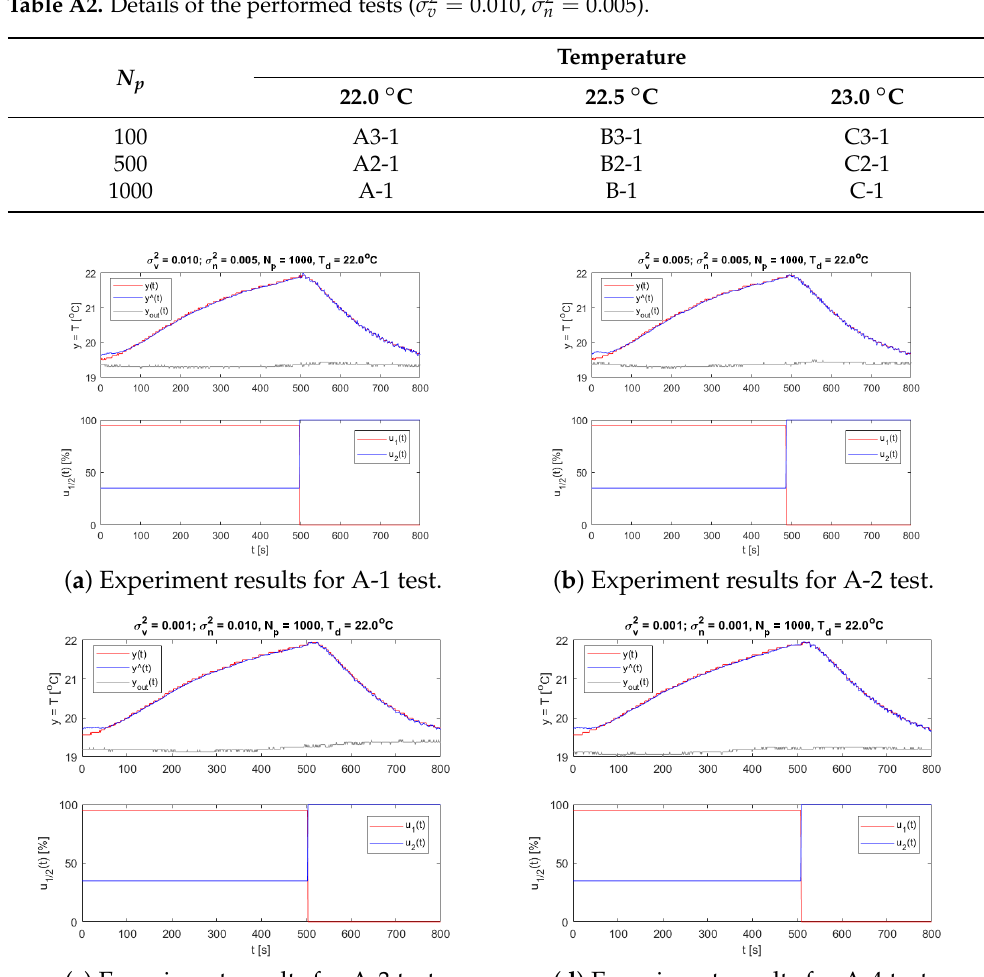
Table A2. Details of the performed tests ( σ 2 v = 0.010, σ 2 n =